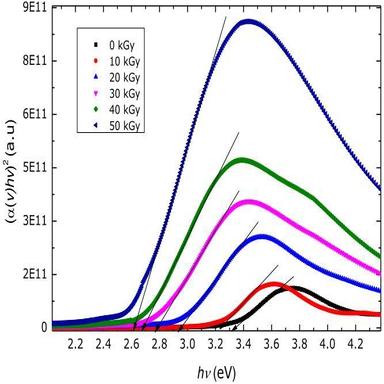
The best fit of energy bandgap for PVA/PANI/functionalized CNT nanocomposite film at different irradiation doses with n = 1/2.